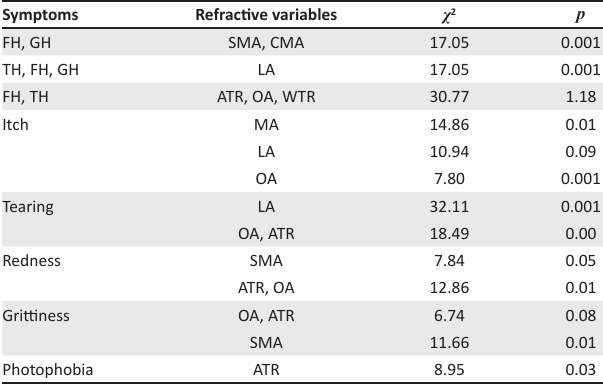
TABLE 4: Associations between asthenopia and refractive errors.